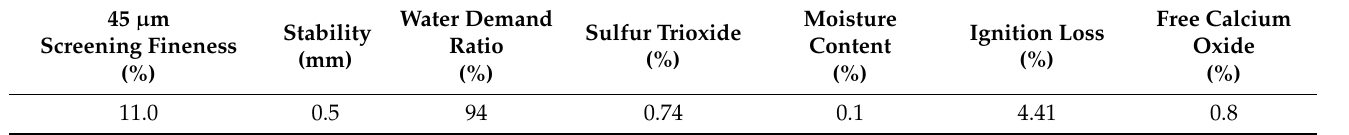
Table 8. Technical indicators of fly ash.